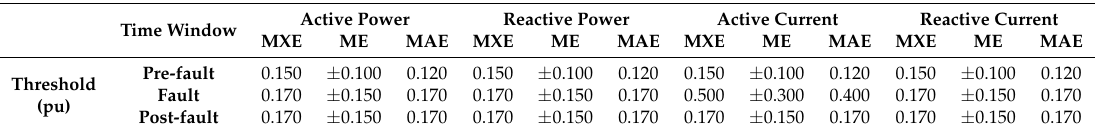
Table 1. Acceptable limits for validation of dynamic WT simulation models as part of the WPP certification process following Spanish NTS and German TG 4 guidelines (see Section